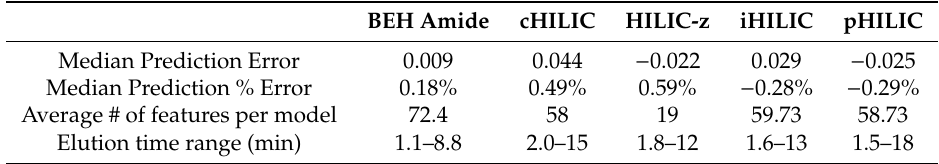
Table 3. Error metrics for QSRR Automator models from different HILIC columns. Elution time range is given as retention time of first observed compound–retention time of final observed compound.